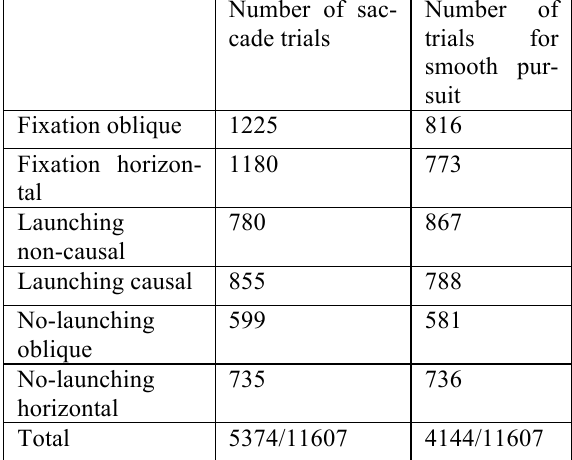
Table 1 : total number of observations for the different experimental conditions.